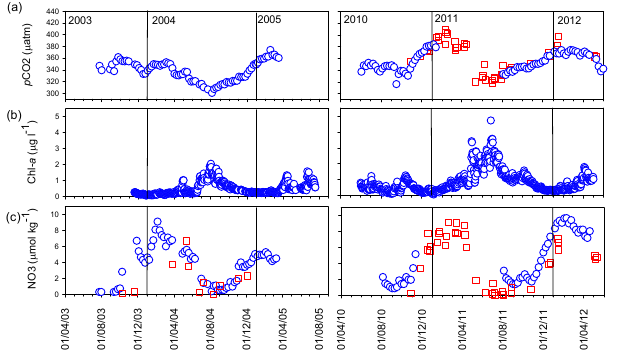
Figure 3. Data from 2003 to 2005 and 2010 to 2012 (blue cir- cles) with vertical lines to represent the start of each year showing: (a) Argo temperature data from 30m depth around the PAP-SO and in situ MicroCAT temperature data at 30m (red circles); (b) cal- culated mixed layer depth (MLD) data; (c) calculations of weekly dissolved inorganic carbon (DIC) concentrations based on in situ PAP-SO p (CO 2 ) and salinity-based TA parameterisations (see text for details) with additional DIC calculations based on SOO data (red circles).